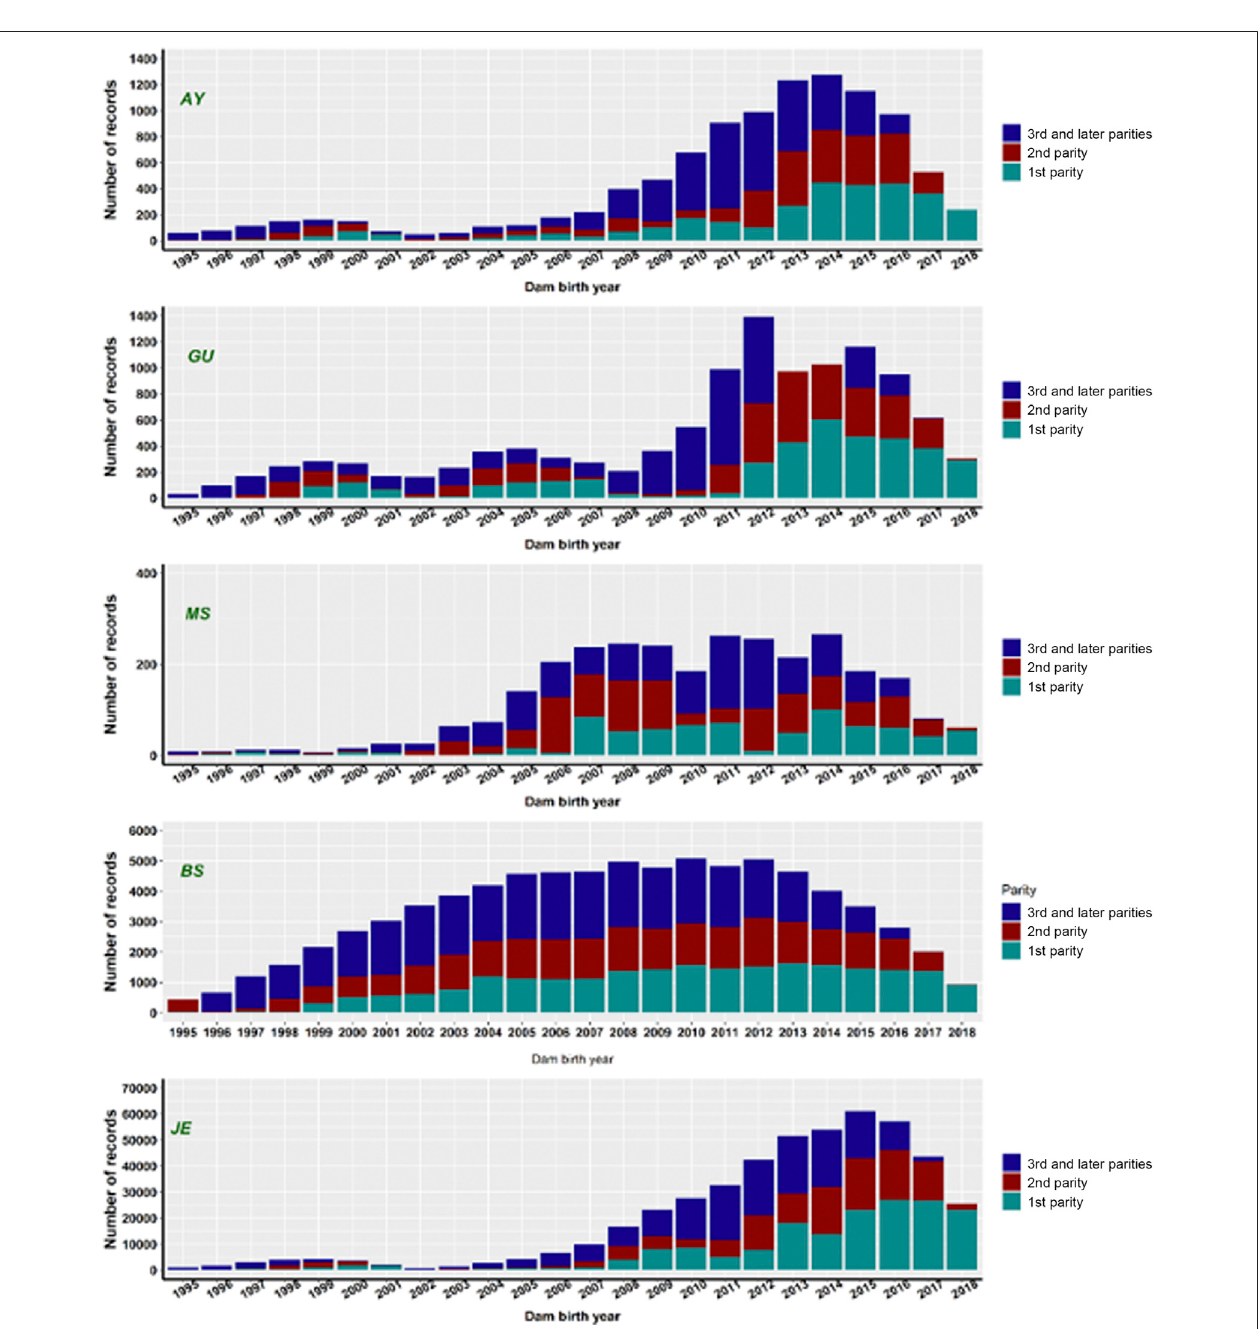
FIGURE 1 | The number of stillbirth records by dam birth year in fi rst, second, third-or-later parities for fi ve non-Holstein dairy breeds. AY = Ayrshire; GU = Guernsey; MS = Milking Shorthorn; BS = Brown Swiss; JE = Jersey.